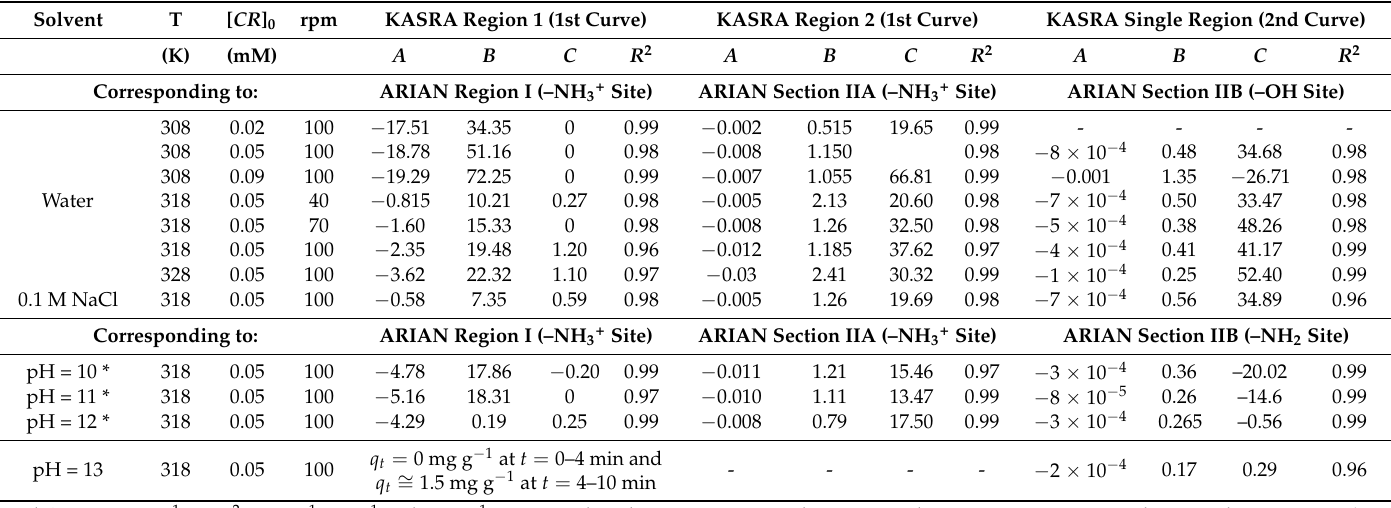
Table 5. Coefficients of the KASRA equation for kinetics of CR adsorption on GO/PAMAM nanocomposite at different temperatures and in various shaking rates and initial CR concentrations.